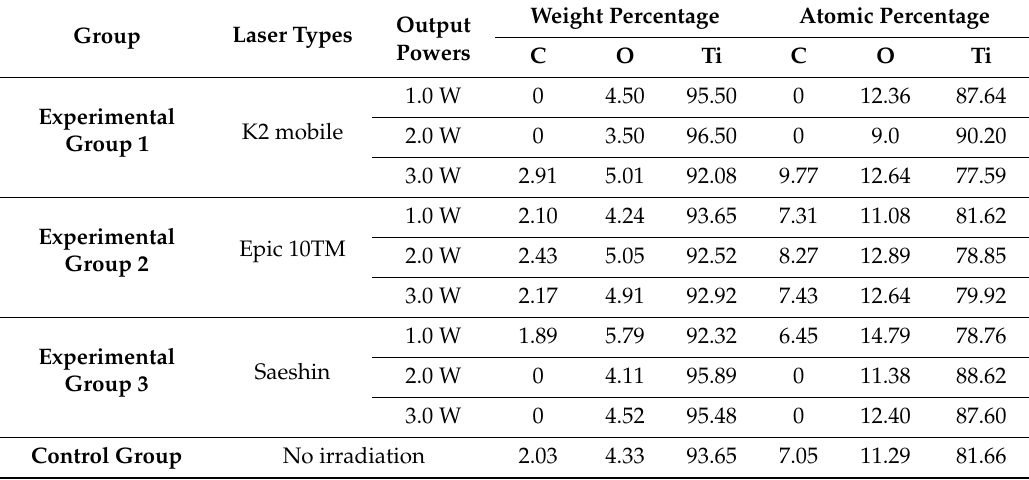
Table 4. Atomic and weight percentages of carbon, oxygen, and titanium atoms on the SLA titanium implants under various laser types and output powers.